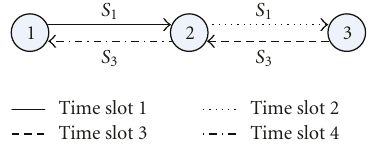
Figure 4: Physical-layer network